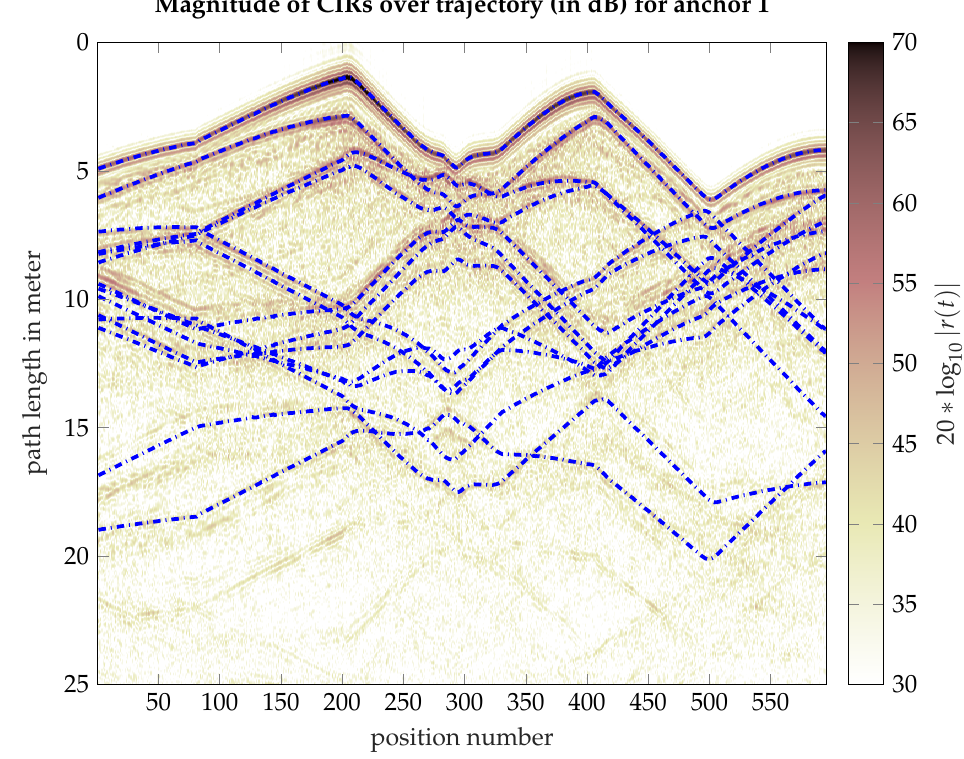
Figure 2. Measured CIRs over the trajectory at a bandwidth of 2 GHz. The blue dash lines indicate expected paths of the SMCs corresponding to VAs up to order two, estimated using the SLAM algorithm from [38,45] and refined as described in [46]. The locations of VAs are shown in Figure 1. A base band signal s ( t ) is transmitted at carrier frequency f c . The complex